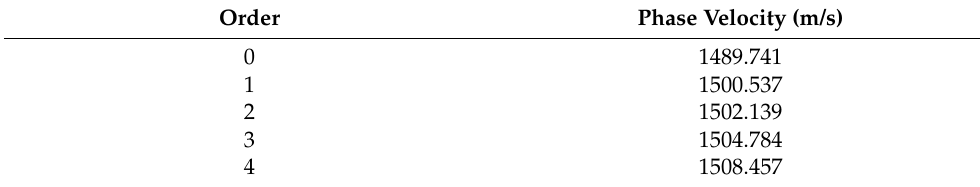
Table 2. Phase velocities of the Scholte wave and normal modes at 10